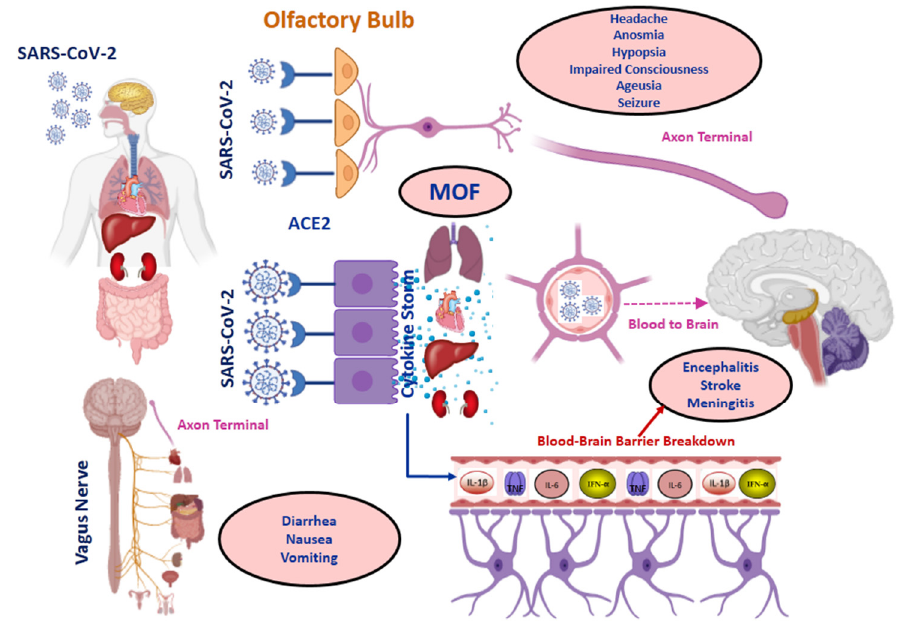
Figure 2. Routes of SARS-CoV-2 invasion. SARS-CoV-2 is mainly transmitted from one person to another by inhalation of droplets. SARS-CoV-2 enters the mucosal cells of the respiratory tract, conjunctiva, and gastrointestinal tract through ACE2 receptors. When the virus comes into contact with the ocular conjunctiva, it could reach the central nervous system via the trigeminal nerve. Although the hypothesis is still controversial, some authors believe that when SARS-CoV-2 comes into contact with the nasal mucosa, it reaches the brain through the olfactory nerve and that the vagus nerve, which innervates the respiratory system, the heart, the digestive system, the kidneys, bladder, uterus, and testicles, is a large route of transfer to the central nervous system. The virus enters the brain via neuronal retrograde transport up to the axonal terminal. SARS-CoV-2 also invades COVID-19 patients through the vasculature and lymphoid pathways. Once the virus has entered the circulation, it can invade the brain through blood-brain barrier breakdown. When the virus comes into contact with the host cell, the innate immune response activates the cytokine storm, particularly during ARDS hypoxia in patients with severe COVID-19. Cytokine storm leads to multi-organ failure (MOF) and damaged blood-brain barrier. With an intact blood-brain barrier, the passage of SARS-CoV-2 to the brain is unlikely [21,22]. This figure was created using the website https://app.biorender.com (accessed on 14 October